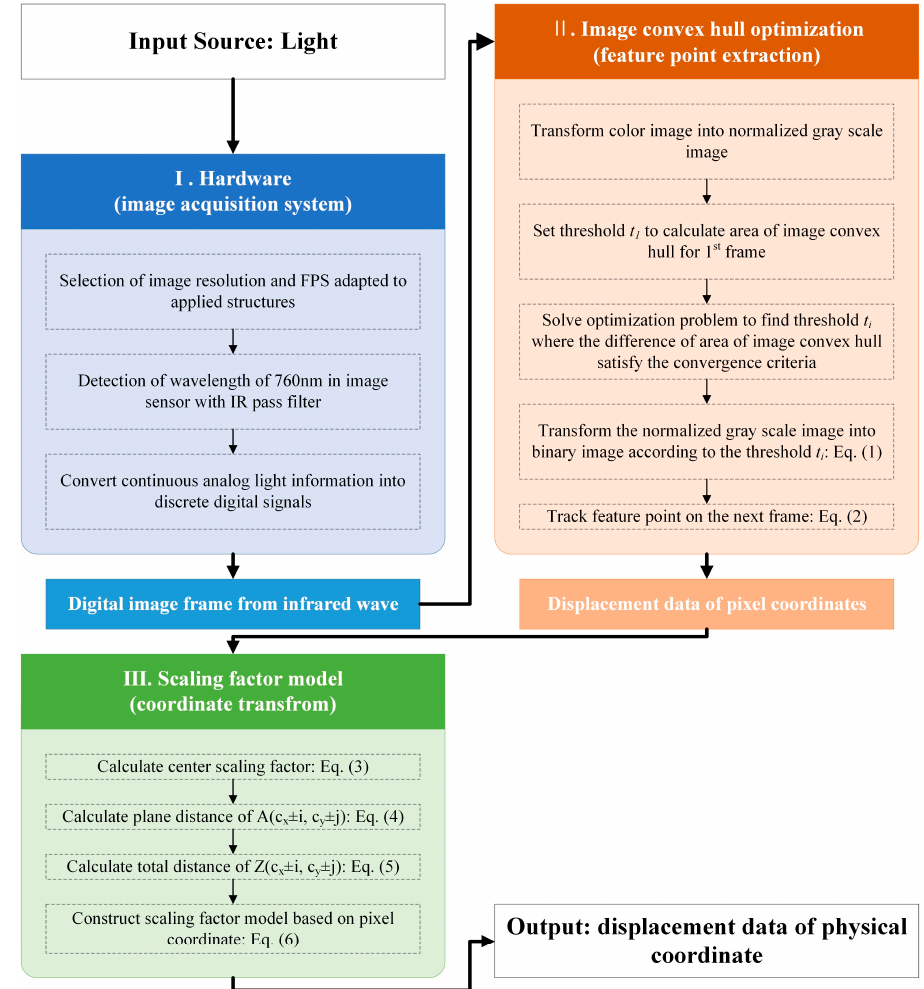
Figure 1. Time domain displacement data acquisition algorithm using night vision optimized displacement sensor (NVDS).